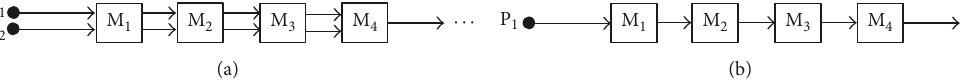
Figure 4: MPC consisting of (a) four machines and two parts and (b) four machines and one part.